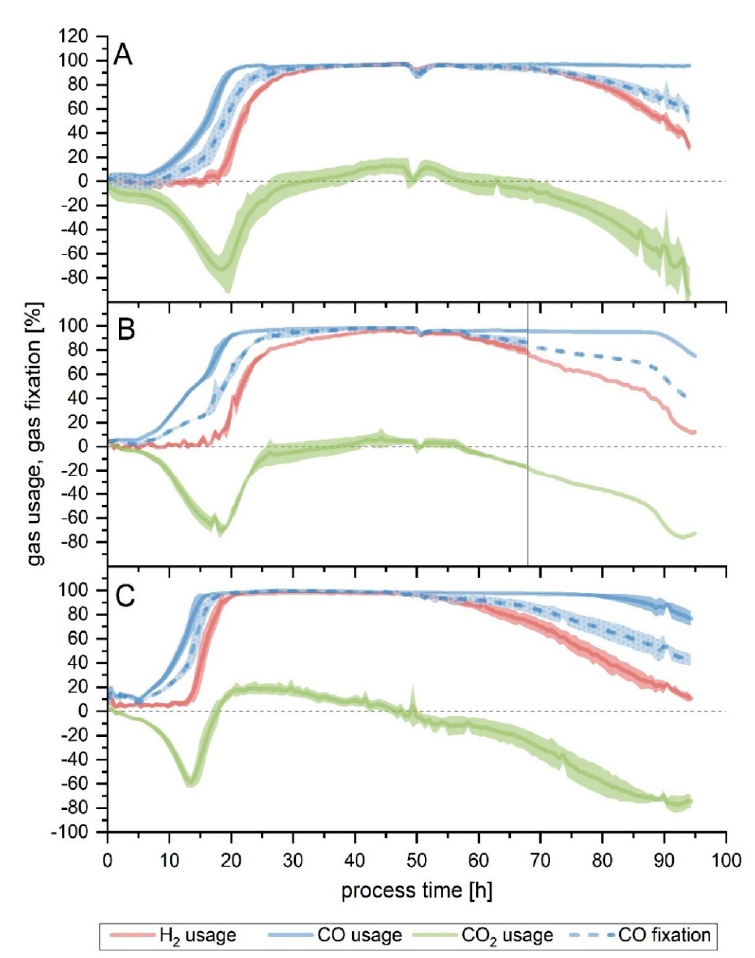
Figure 2. Substrate usage or fixation for: Setup 1 ( A ); Setup 3 with increased cysteine ( B ); and Setup 4 with increased yeast extract ( C ). In ( B ), the average of two fermenters is shown up to 68 h (vertical line). Afterwards, only the fermenter kept at pH 5.9 is shown (Setup 3a). One fermenter has been left out of the averages due to being remarkably delayed in comparison with the other two. Usage is shown for H 2 (red line), CO 2 (green line) and CO (blue line). CO fixation is depicted by the dotted blue line. Except where otherwise stated, lines show the average of a triplicate ( n = 3), while the lighter colored areas depict the standard deviation.